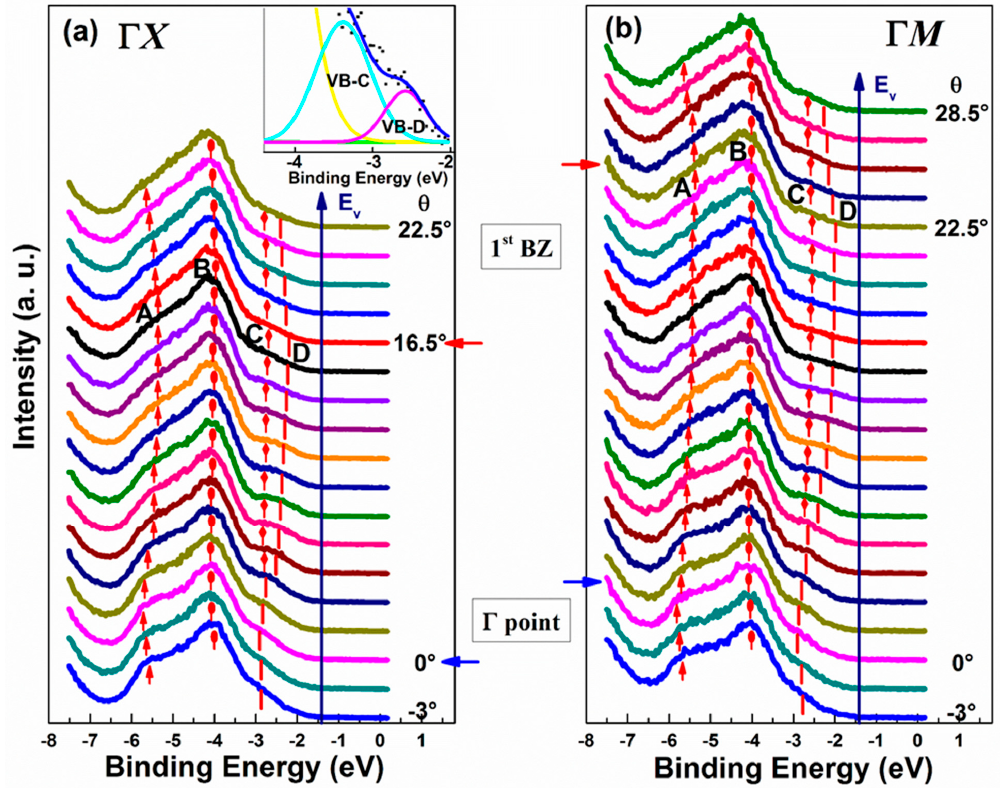
Figure 13. ( a ) Angle-resolved energy distribution curves of MAPbBr 3 measured along Γ X ; ( b ) Angle-resolved energy distributions curves of MAPbBr 3 measured along Γ M . The four VB peaks are denoted by arrows and bars. The inset shows the detailed fitting of VB-C and VB-D peaks. From Ref. [104] with permission.